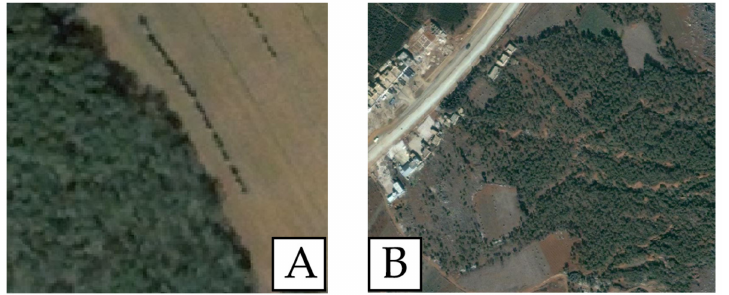
Figure 14. Diagram of forest areas bordering agricultural land and buildings. ( A ) Forest areas bordering agricultural land; ( B ) Forest areas bordering